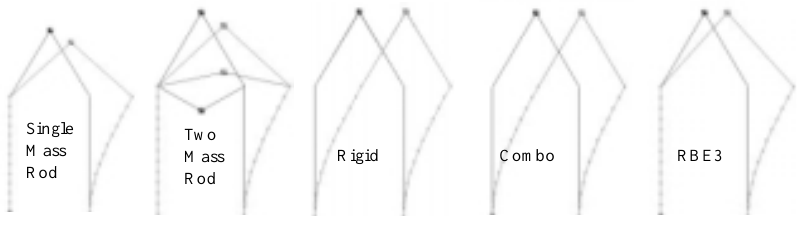
Fig. 9. Static analysis deformation plots.